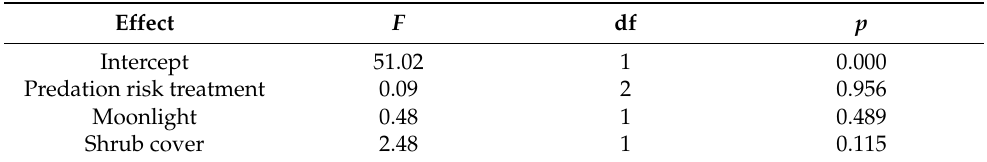
GLM analyzing the effects on slow locomotor activity was not statistically significant (Table 7; omnibus test F = 9.224; df = 4; p = 0.056). Vigilance behavior was significantly affected by predation risk treatment and moonlight (Table 8). Mean total time per event allocated to vigilance was significantly lower in the control (9.08 ± 1.83 s; N = 57) compared to the G. nana (23.05 ± 2.00 s; N = 88) and S. rufipes treatments (18.51 ± 3.00 s; N = 37) (Figure 3b). Regarding moonlight, mice increased their vigilance when moonlight reached intermediate levels (Figure 4). Table 5. Results of the GLM analyzing the effect of experimental and environmental factors on O. longicaudatus feeding behavior.